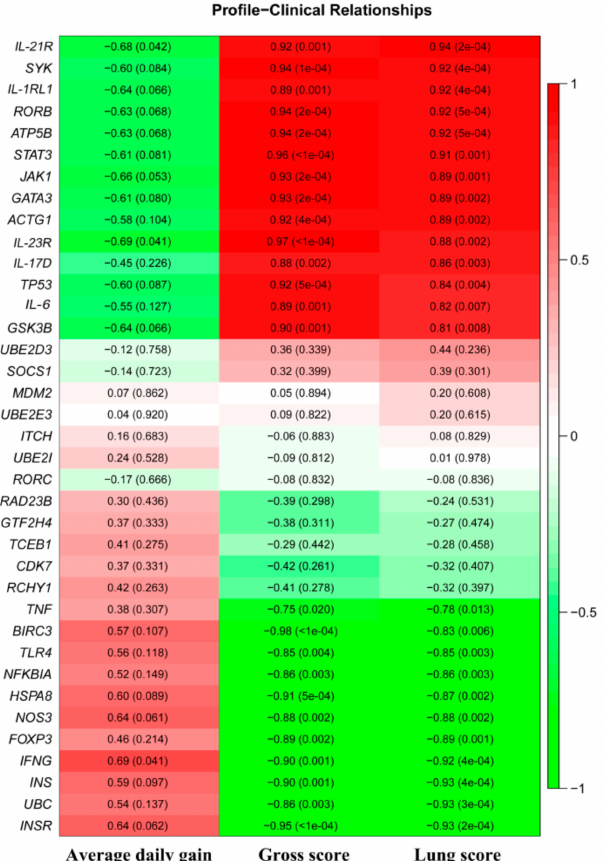
Figure 6. Correlation of DEGs with clinical trait scores. The color of each box represents the direction of correlation (red = positive correlation; green = negative correlation). The coe ffi cient of r value is in the corresponding box, with p value in parentheses. Pearson’s correlation was used to determine the significance of correlation ( p < 0.05) between the individual genes and clinical traits, including daily gain, gross score, and lung